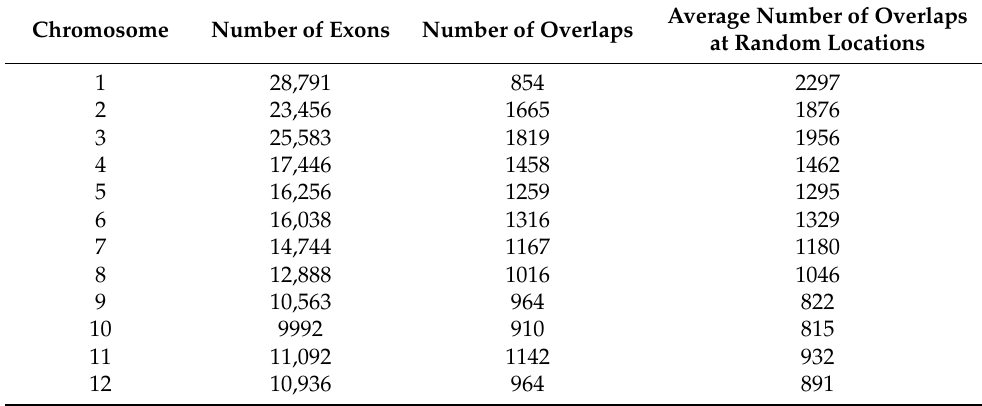
Table 4. Intersection between exons and regions containing tandem periodicity in rice